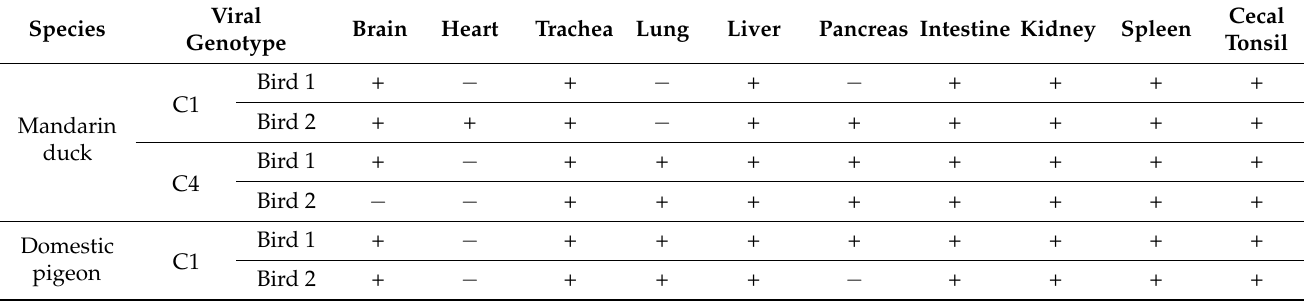
Table 2. Immunohistochemistry for influenza virus detection in mandarin ducks and domestic pigeons. Species